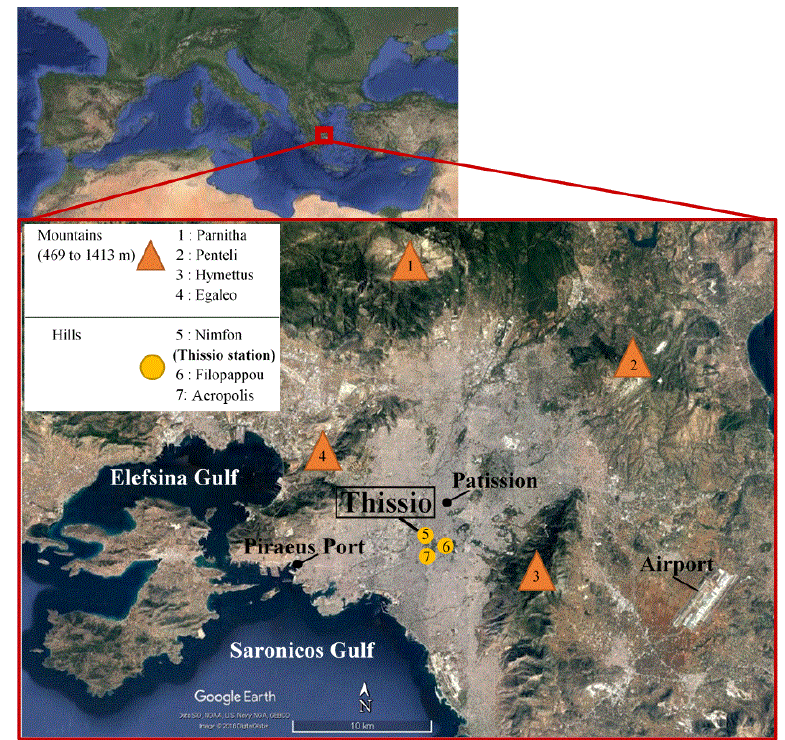
Figure 1. Map of the greater Athens area. The four mountains listed in the legend define the borders of the study area.